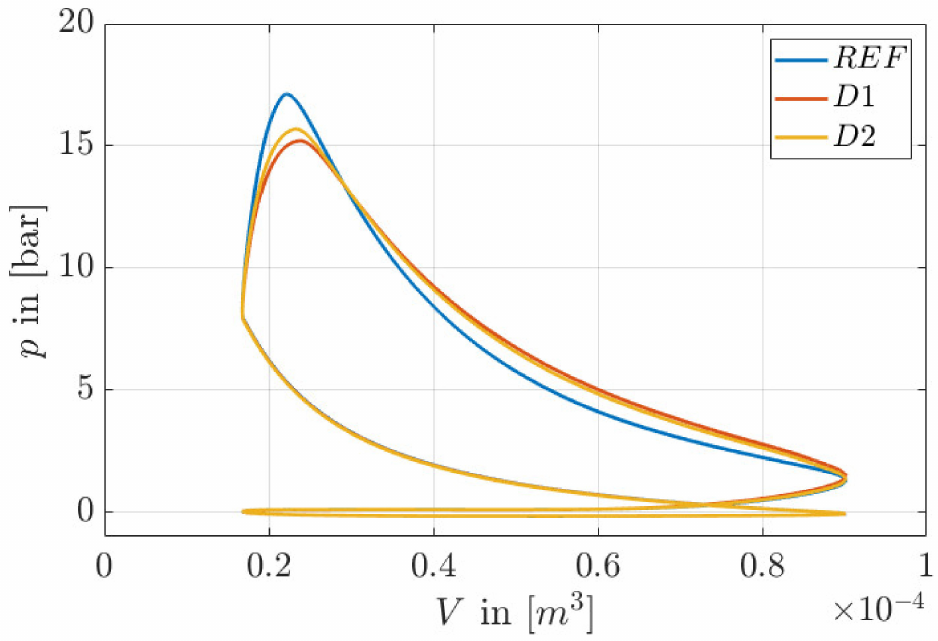
Figure 31. Comparison of trajectories REF, D1 and D2 related to the energy conversion of the internal combustion engine: cylinder pressure depending on volume.